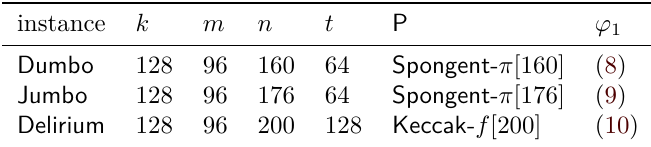
Table 1: Instances of